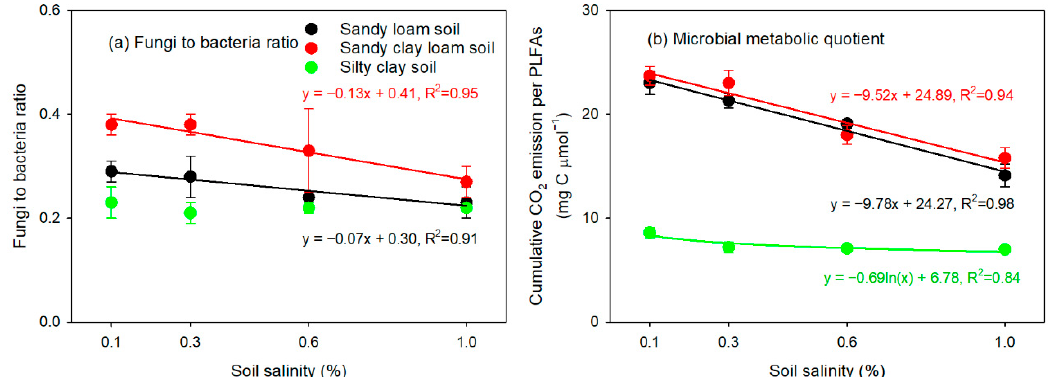
Figure 5. Relationships of the PLFA-distinguishable fungi-to-bacteria ratio ( a ) and microbial metabolic quotient ( b ) with salinity in the sandy loam soil, sandy clay loam soil and silty clay soil. Error bars indicate the standard error of the mean ( n = 3).